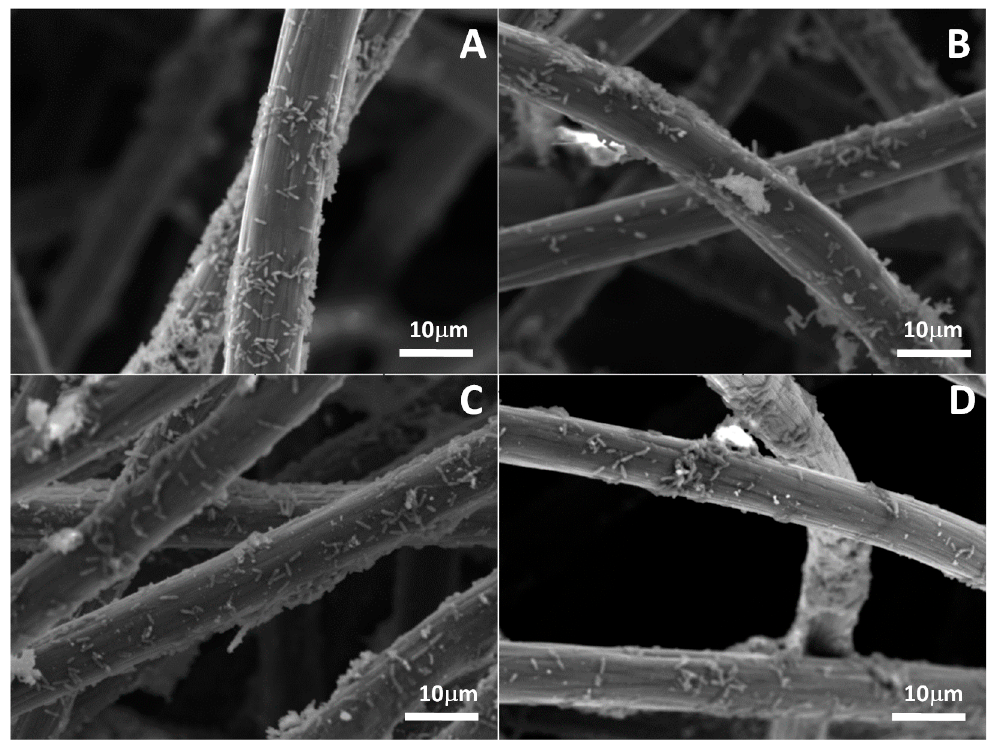
Figure 6. SEM image of the cathode electrode surface with different redox mediators. ( A ) Control, ( B ) NR, ( C ) HNQ, ( D ) HQ. Table 2. Analysis of the protein attached to the cathode electrode surface and planktonic cells using different mediators.